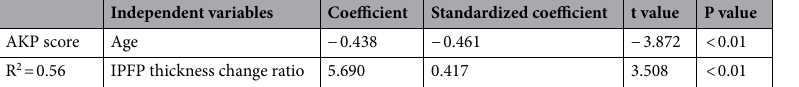
Table 3. Factors associated with AKP scores on stepwise regression analysis. AKP anterior knee pain, IPFP infrapatellar fat